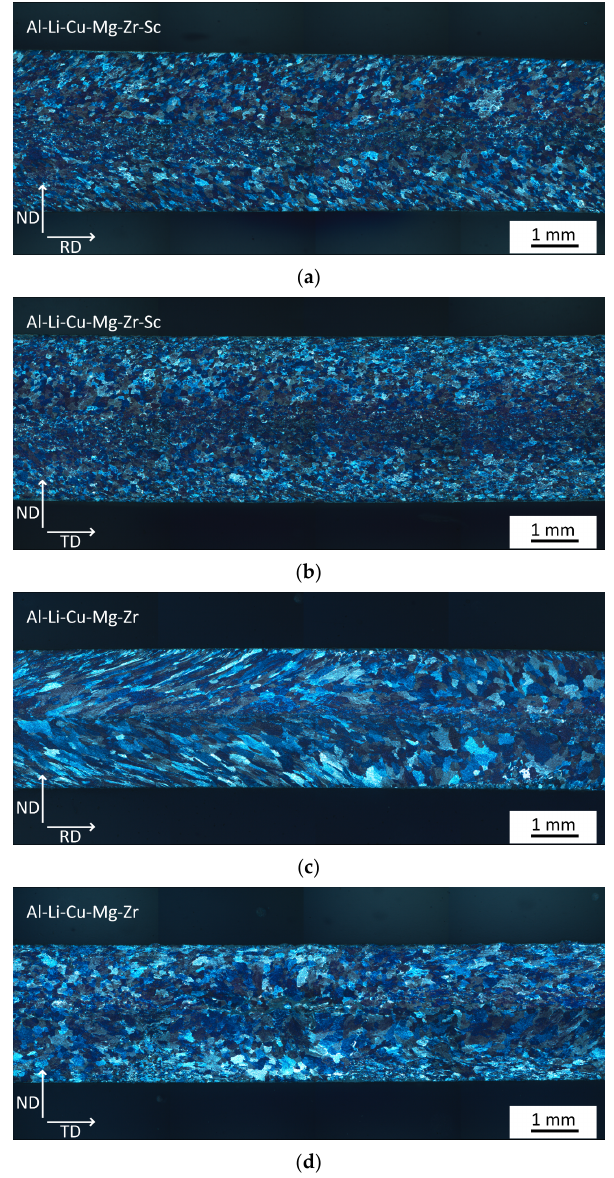
Figure 1. Grain microstructure in as-cast Al-Li-Cu-Mg-Zr-Sc ( a , b ) and Al-Li-Cu-Mg-Zr ( c , d ) alloys in sections perpendicular to transverse ( a , c ) and rolling ( b , d ) directions. ND stands for normal direction.